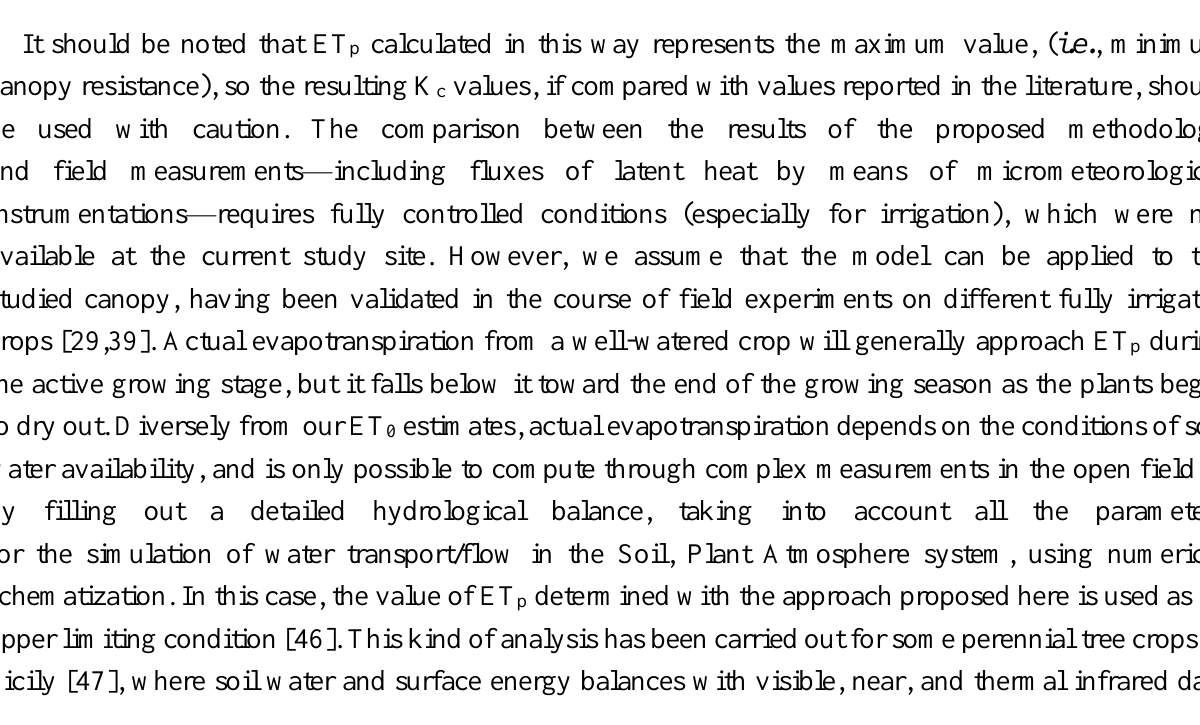
Figure 3. Field estimates of LAI collected on 23–24 July 2014 with a LICOR LAI-2000 Plant Canopy Analyzer. The filled circles show the average LAI with the standard